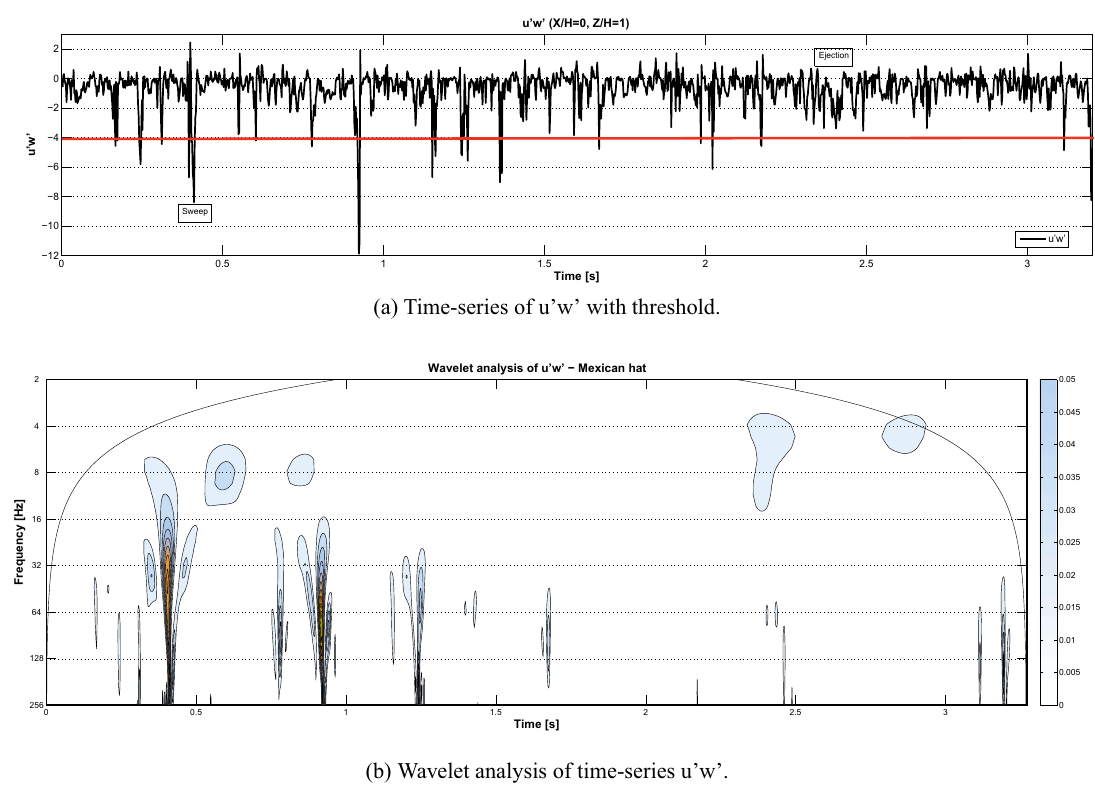
Fig. 6: Time-series of ’u’w’ at point X / H = 0, Z / H = 1 (a) and its Wavelet analysis using Mexican hat (b). error into the time-series of sweep and ejection notwith- standing due to a certain exclusivity above threshold, the data were only slightly modified. The time-series with the sweep (red thin line) and the ejection (green thin line) rel- ative contribution and final data-series (black thick line) is depicted in Figure 7b.